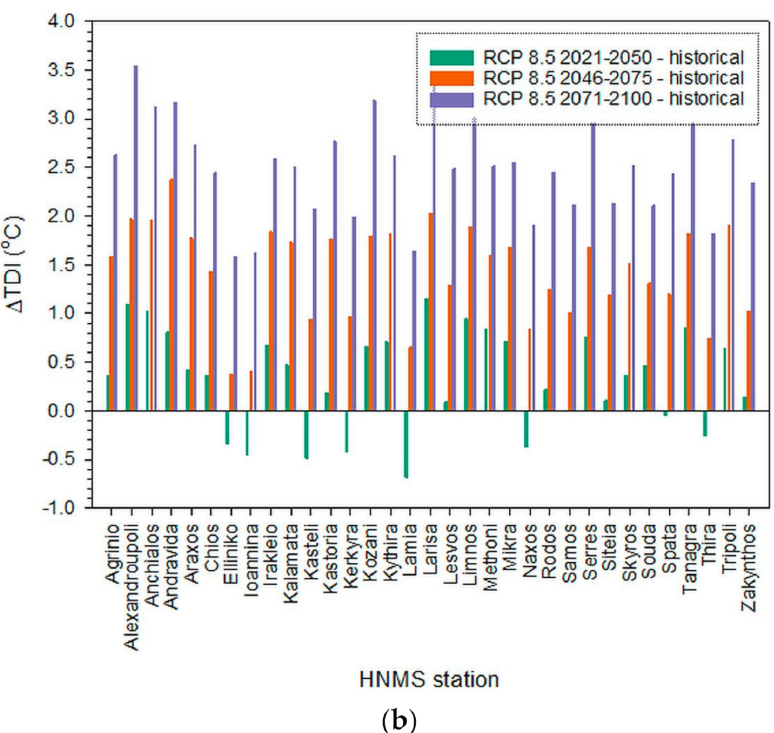
Figure 6. Intra-annual variation of the mean ∆ TDIs as derived from the TMYs-MC during the historical period of 1985–2014 and the future epochs of 2021–2050, 2046–2075, 2071–2100 under the ( a ) RCP 4.5 and ( b ) RCP 8.5 IPCC scenarios. The definition of ∆ TDI s is given in the text.